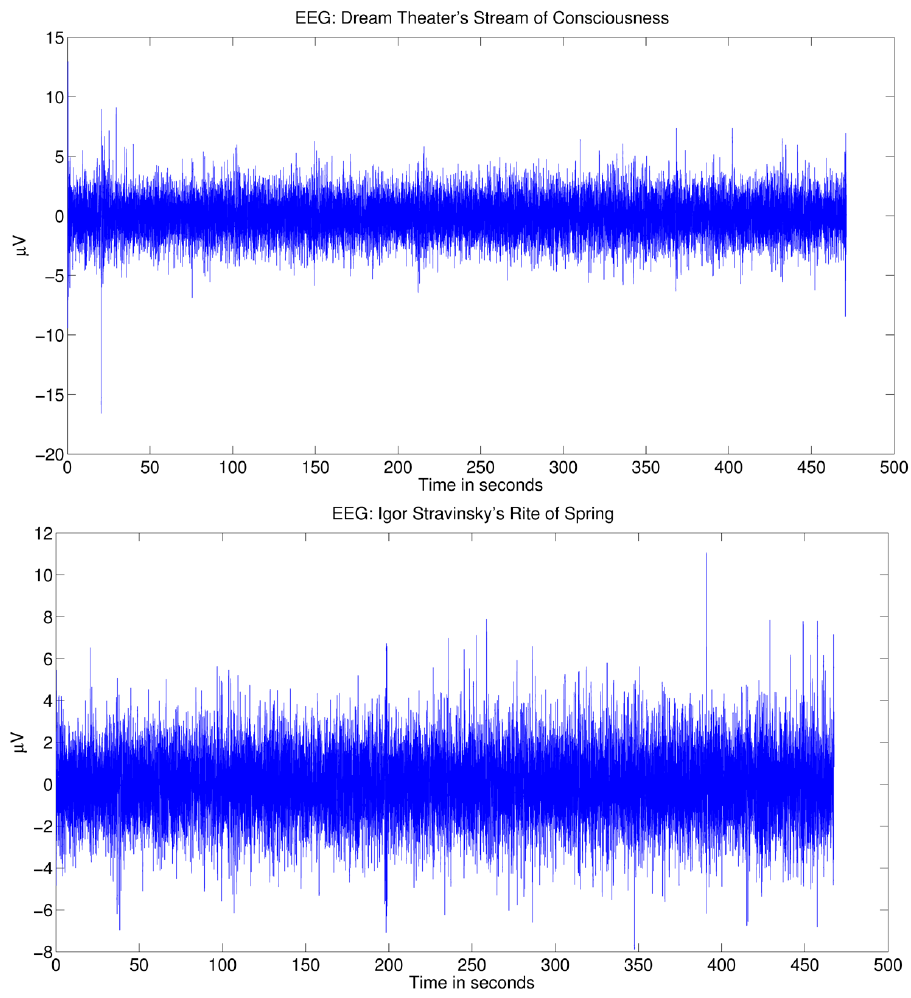
Figure 3. EEG waveforms. Showing grand average EEG across listeners measured at the Cz electrode. Responses to the novel loudness increase at 20.316 s ( top ) and the novel chord at 198.646 s ( bottom ) are visible.